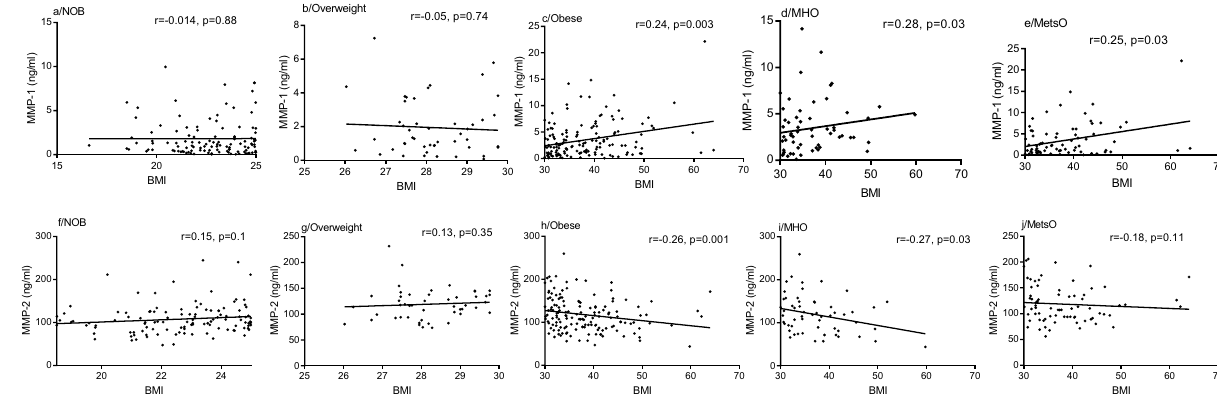
Figure 1. Spearman Rank correlation between BMI and MMP-1 and MMP-2 plasma levels respectively, according to obesity status. Regression coefficient (r) and statistical significance (p) are reported for each test. p-value < 0.05 is significant. BMI Body Mass Index, NOB non-obese, MHO metabolic healthy obese, MetsO metabolic syndrome with basal CVC in people with obesity (r = − 0.47, p = 0.004, Fig. 4c), however, no correlation was found among non-obese and overweight people (r = 0.28, p = 0.16; r = 0.65, p = 0.15, Fig. 4a,b, respectively). Additionally, a negative correlation was found between MMP-9 levels and basal CVC in MetsO (r = − 0.61, p = 0.007, Fig. 4e), however, no correlation was found among MHO (r = − 0.43, p = 0.9, Fig. 4d). MMP-9 levels and MMP-9/TIMP-1 ratio showed no correlation with peak Ach-CVC among MHO (r = − 0.35, p = 0.13, Fig. 4i; r = − 0.24, p = 0.31, Supplementary Table 2), overweight (r = 0.05, p = 0.91, Fig. 4g; r = 0.08, p = 0.84, Supplementary Table 2) and non-obese people (r = 0.18, p = 0.33, Fig. 4f; r = 0.17, p = 0.34, Supplementary Table 2). While MMP-9 levels and MMP-9/TIMP-1 ratio were negatively correlated with peak Ach-CVC in obese (r = − 0.45, p = 0.005, Fig. 4h; r = − 0.46, p = 0.004, Supplementary Table 2) and MetsO subjects (r = − 0.58, p = 0.01, Fig. 4j; r = − 0.53, p = 0.03, Supplementary Table 2). In addition, MMP-2 levels and MMP-2/TIMP-2 ratio were positively correlated with Peak Ach-CVC among MetsO group (r = 0.55, p = 0.02; r = 0.6, p = 0.01; Supplementary Table 2), however, no correlation was found among other groups (Supplementary Table 2). Linear regression analysis also identified that the MMP-9/TIMP-1 ratio is an independent variable affecting Peak-Ach-CVC in obese, MHO and MetsO subjects (Supplementary Table 3). Additionally, MMP-1, MMP-9, and MMP-1/TIMP-1 ratio were considered as independent variables affecting Peak Ach-CVC in MetsO subjects (Supplementary Table 3). The Bêta coefficient (β) for valences indicates the direction of the relationship between the predicted variable and the independent variables. In this regard, the probabilities of impaired endothelial function in obese subjects increase when the parameters MMP-9, MMP-1, MMP-1/TIMP-1, and MMP-9/TIMP-1 ratios increase in obese or in MetsO subjects (Supplementary Table 3). Spearman correlation between MMPs or TIMPs plasma levels and CRP.